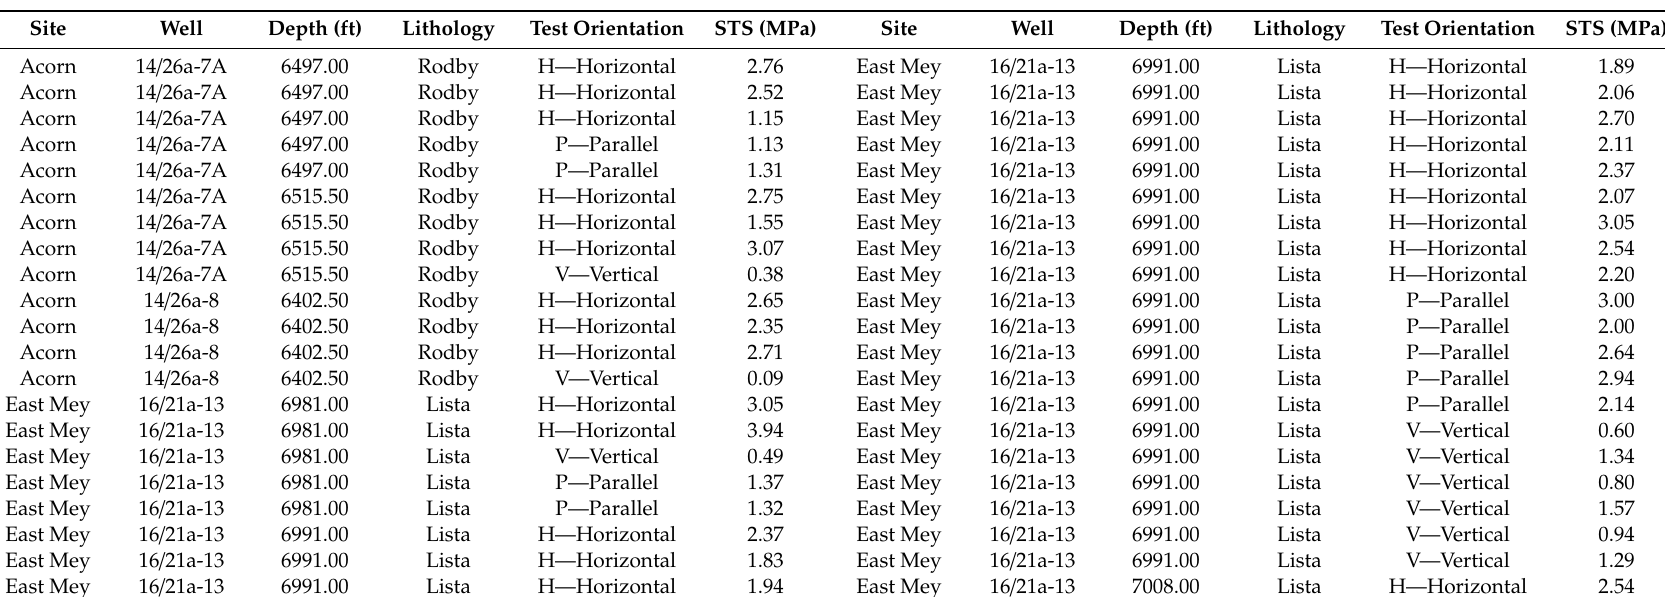
Table 3. Splitting tensile strength summary data from the Acorn and East Mey sites. In total, 42 measurements were made including repeats. The tests were made at di ff erent orientations with respect to bedding (see Figure 12): H is horizontal to bedding, P is parallel to bedding, and V is vertical to bedding. Overall, the horizontal samples represent the highest tensile strength (mean values of ~2.5 GPa) of both the Lista and the Rodby